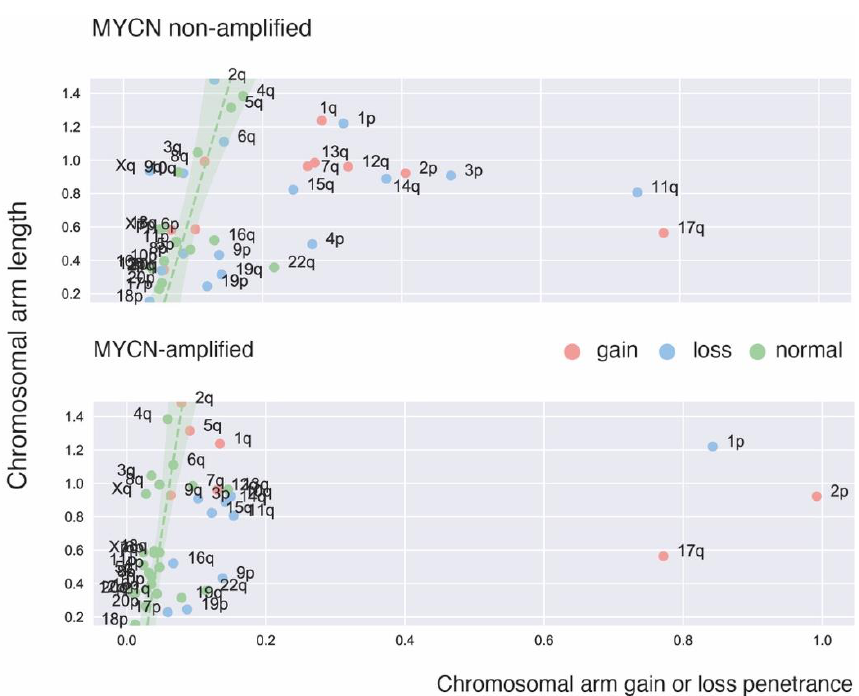
Figure 1. Correlation between chromosome arm length and amount of gains and/or losses on the arm in a dataset of 542 high-risk primary NB tumors [38] showing recurrent copy number imbalances in MYCN non-amplified and MYCN -amplified tumors. Gains or losses that spanned both chromosomal arms where not withhold. For every chromosomal arm the ratio of gains versus losses was analyzed in a binomial test to establish whether either the number of gains was exceptional in respect to the number of losses or the other way around. If a significant amount of gains was found for the total number of gains and losses, the chromosomal arm is displayed in red, if the other way around in blue, and if both losses and gains on the arm were on par ( p -value binomial test ≥ 0.05) they are displayed in green. The ‘ green ’ arms were used to calculate a linear regression between chromosomal arm length and total number of combined losses and gains. The standard deviation on this linear regression is depicted in a shaded green area to indicate where normal amounts of gains and losses lie for the chromosome arms of different length. Outliers can now easily be identified in the two MYCN groups and comprise the usual suspects.